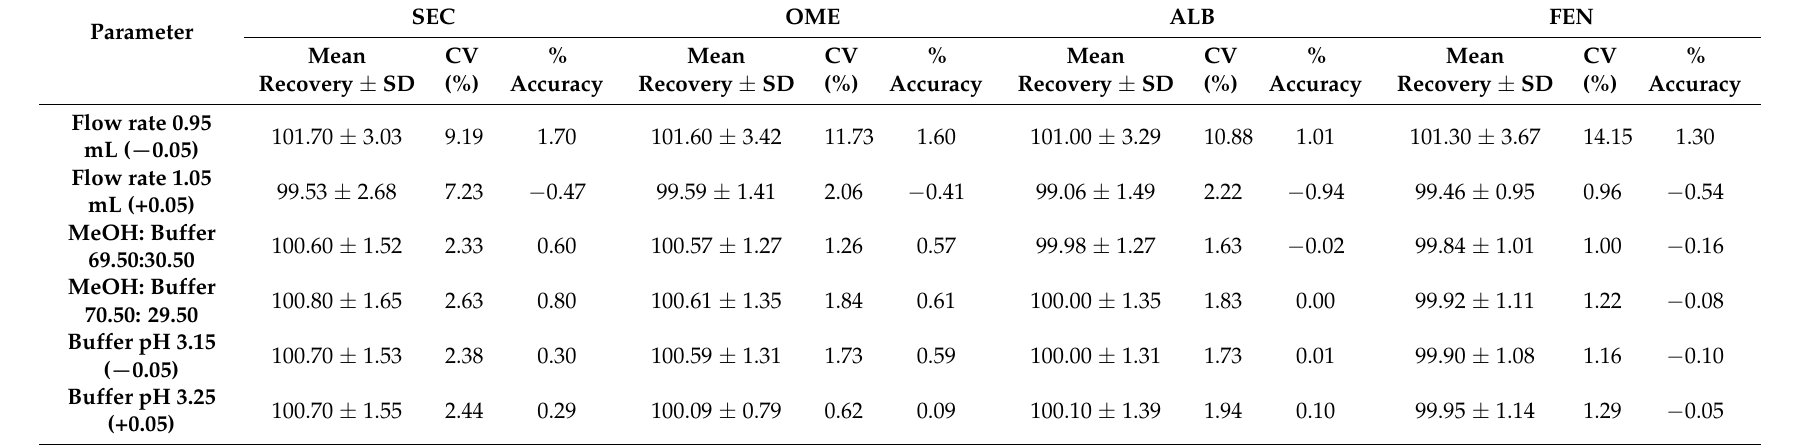
Table 6. Results of the robustness for the determination of SEC, OME, ALB, and FEN (50 µ g/mL) using the proposed method.